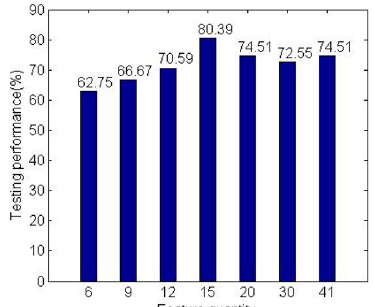
Figure 10 The relationship between the test accuracy of BPNN and sample feature